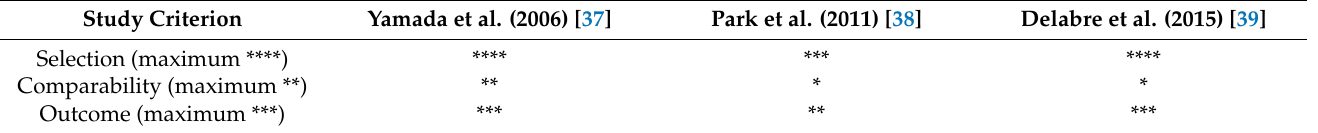
Figure 2. Assessment of risk of bias for RCTs. ( A ) Risk of bias graph showing each item presented as percentages across all RCT studies ( B ) Risk of bias summary showing each item for each study. Table 2. Overall scientific quality of the cohort studies based on the Newcastle–Ottawa Scale (NOS).